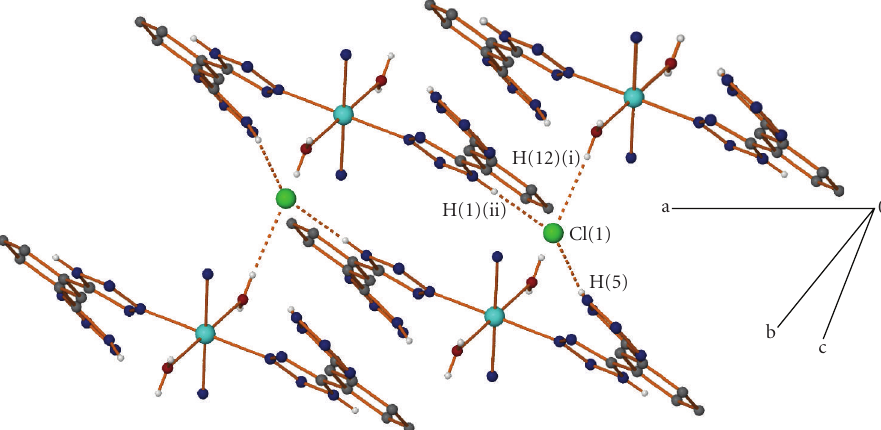
Figure 2: A projection of the hydrogen bonded layer formed in 1 , parallel to a axis. The organic hydrogen atoms and acetonitrile carbon atoms have been omitted for